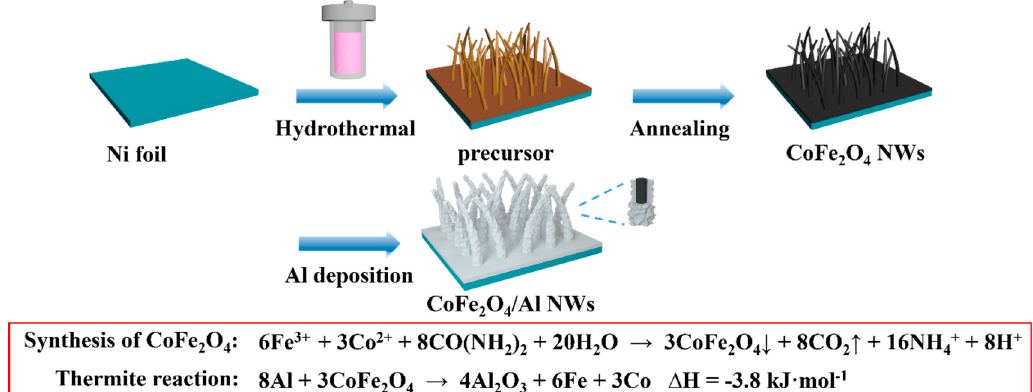
Figure 1. Schematic diagram for the fabrication of the core/shell CoFe 2 O 4 /Al nanothermite film.